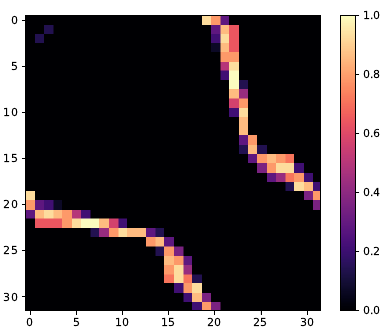
Figure 13. A sample measurement vector reshaped to a 32 × 32